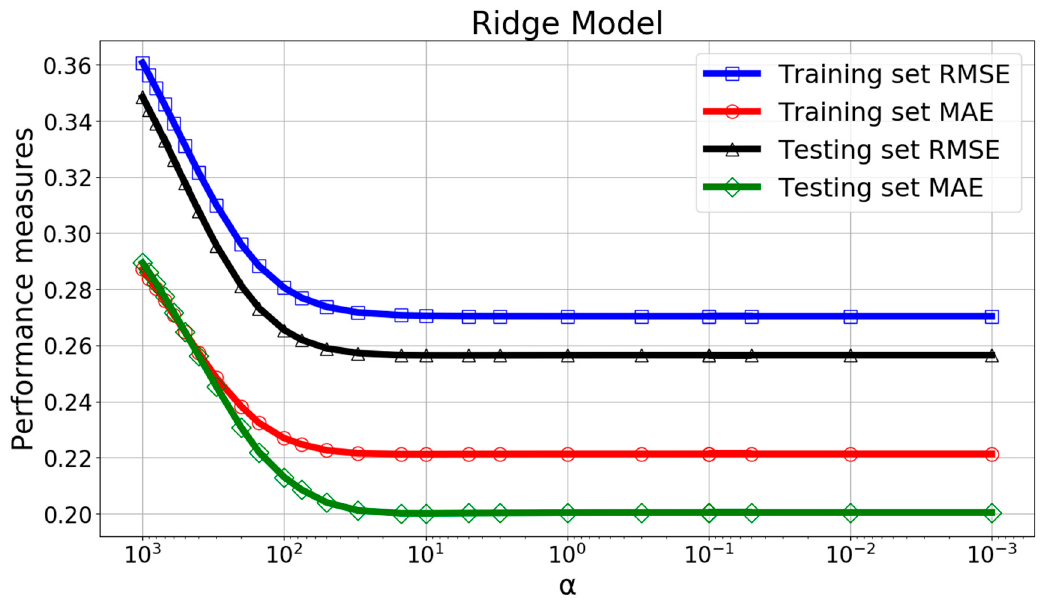
Figure 7. Root mean square error (RMSE) and mean absolute error (MAE) versus parameter α for the Ridge model.